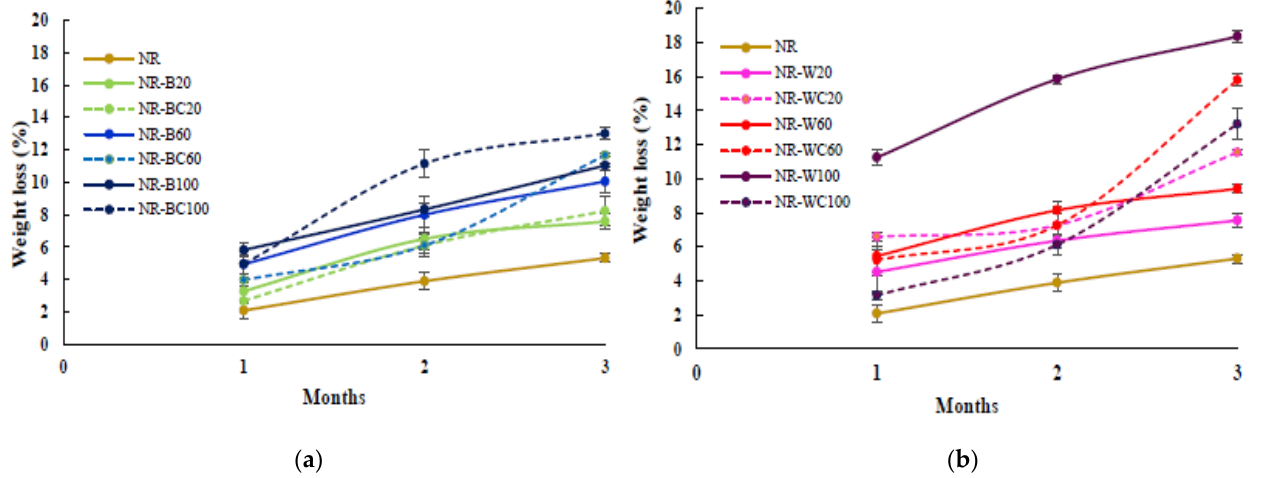
Figure 10. Preliminary test for biodegradation in soil of NR, NR–B, NR–BC ( a ) and NR–W, NR–WC ( b ).